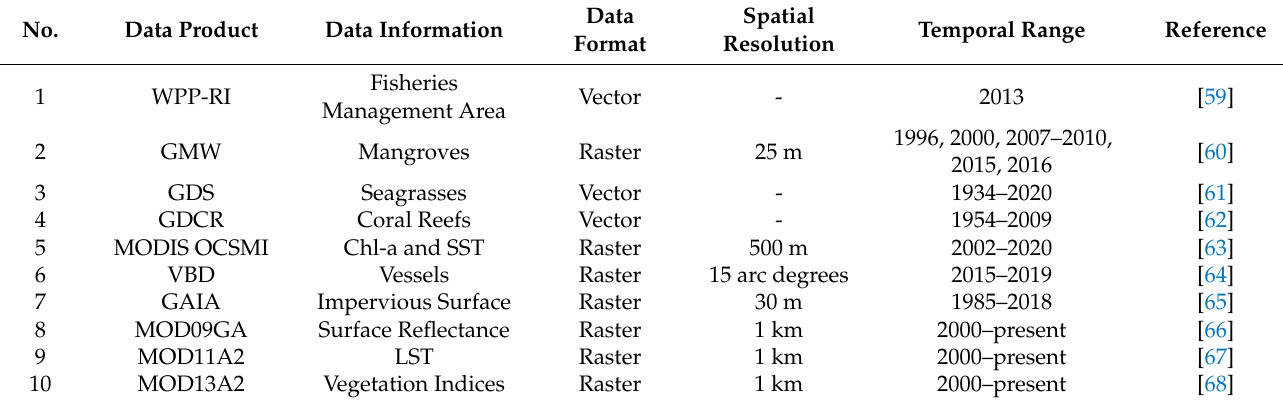
Table 1. Specifications of the data products. WPP-RI: fisheries management areas; GMW: global mangrove watch; GDS: global distribution of seagrass; GDCR: global distribution of coral reefs; MODIS OCSMI: moderate resolution imaging spectroradiometer ocean color standard mapped images; VBD: VIIRS (visible, infrared imaging radiometer suite) boat detection; GAIA: global artificial impervious area; MOD09GA: MODIS surface reflectance; MODIS11A2: MODIS land surface temperature; MOD13A2: MODIS vegetation indices; Chl-a: chlorophyll-a; SST: sea surface temperature, and LST: land surface